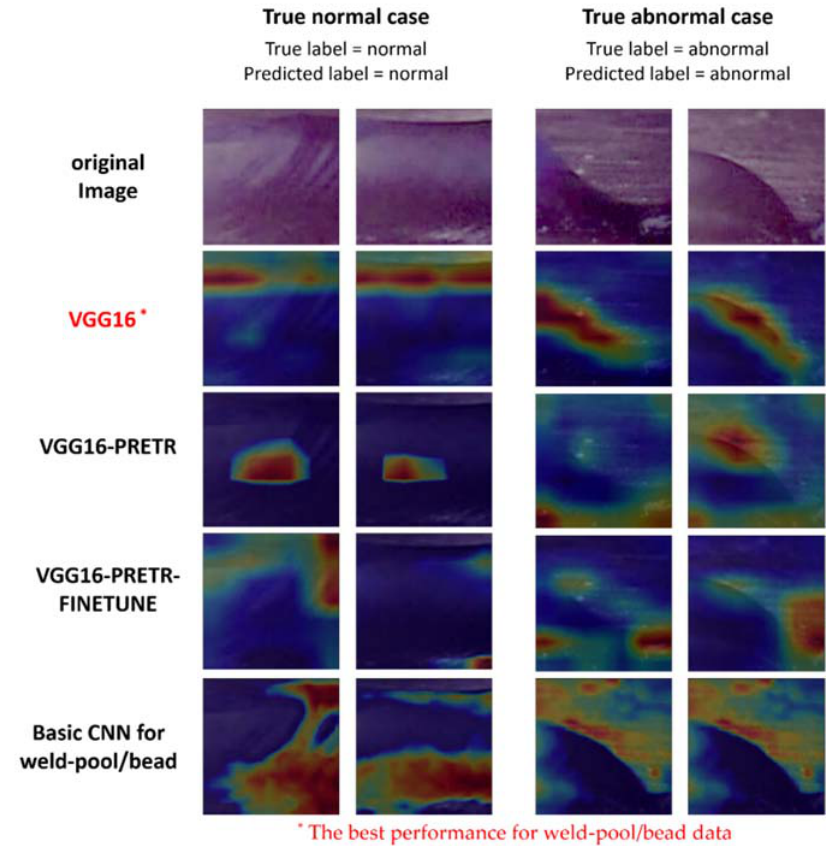
Figure 13. Visual verification by Grad-CAM for